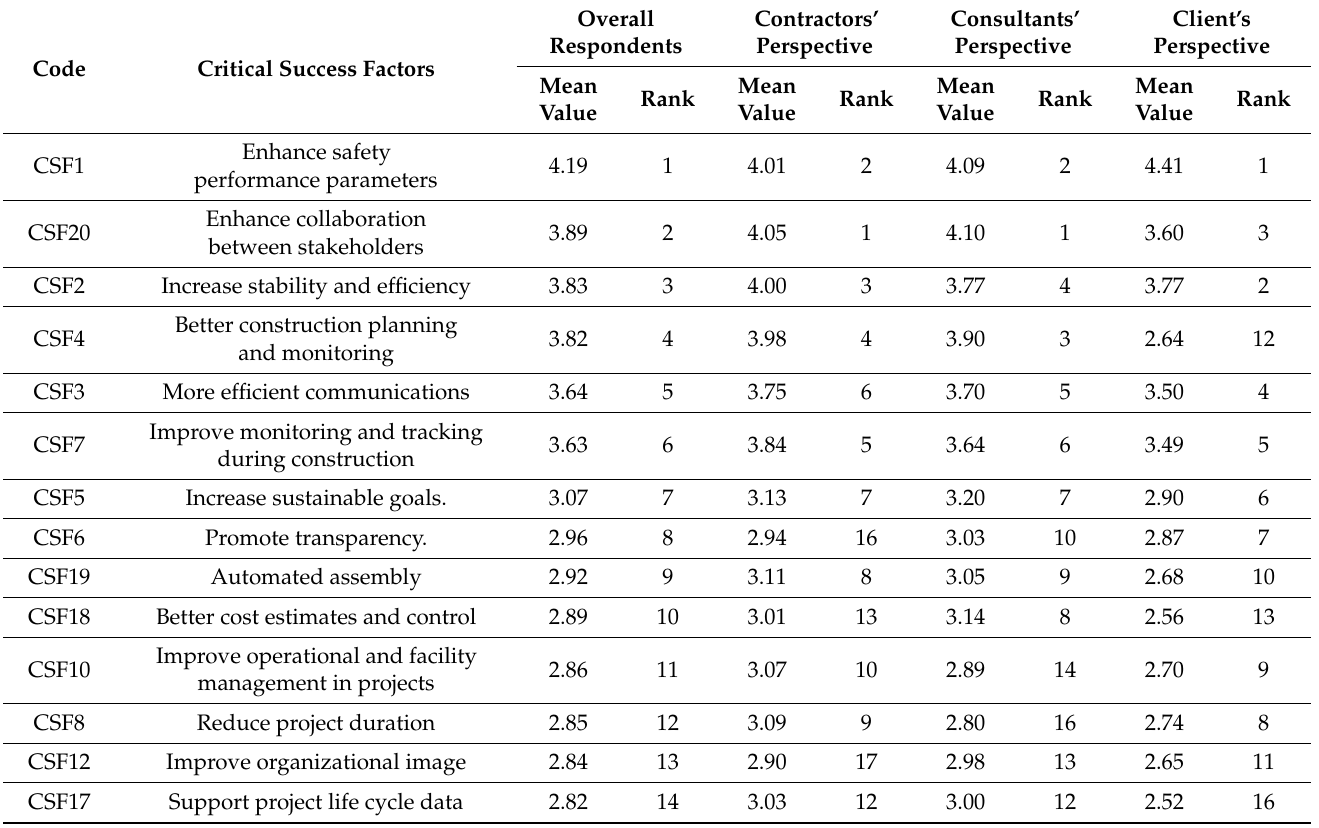
Table 2. Ranking of CSFs of BIM implementation.